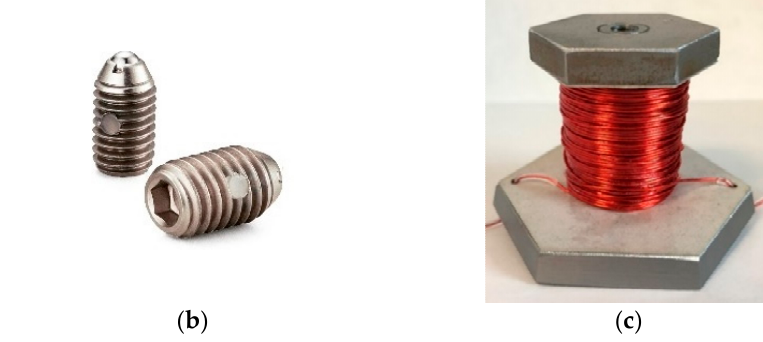
Figure 4. Stator poles and bearings: ( a ) assembled regular hexagonal pole unit showing tapped M6 threading for Hudson bearings; ( b ) M6 Hudson bearings assembled into the hexagonal poles; ( c ) wound stator pole ( N = 522 turns of 24 AWG magnet wire).